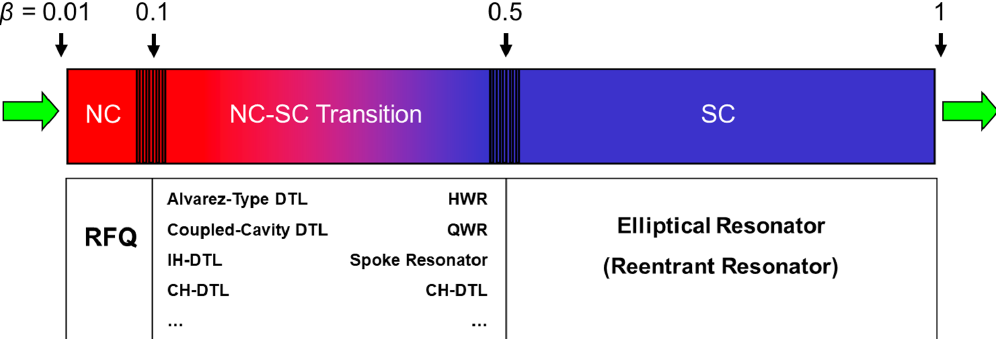
fields.FIG. FIG. 2. Alvarez-type (left), HWR (middle), and H-type (right) structures with electric FIG. 3. Schematic plot for particle trajectories in the longitudinal phase space at ϕ s ¼ − 30 ° (left) or ϕ s ¼ 0 °